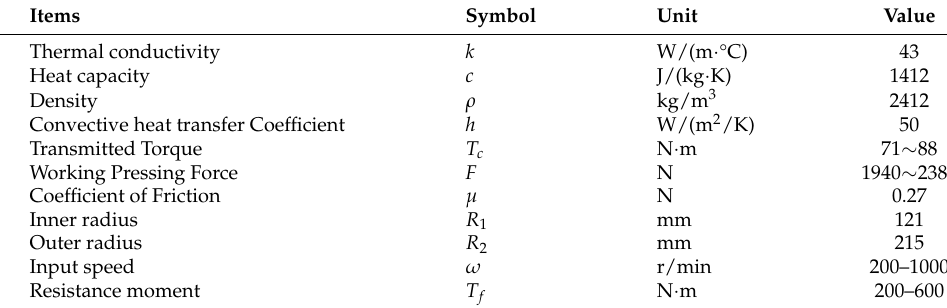
Table 1. Parameters for experiments.